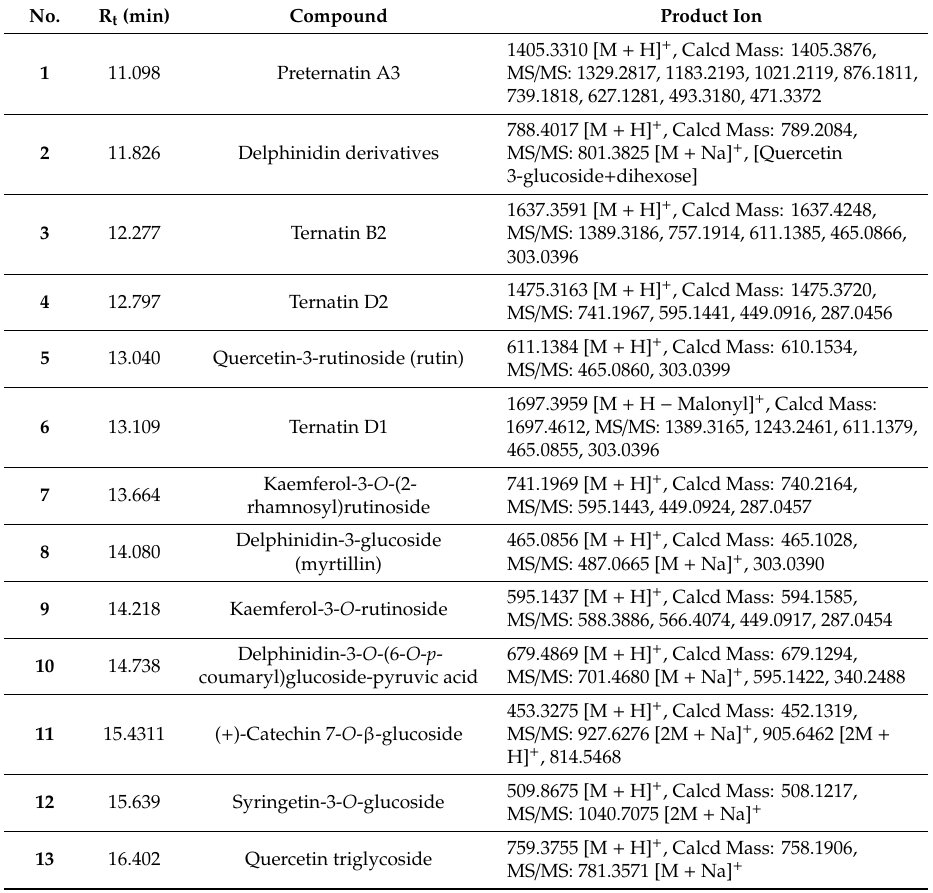
Figure 1. LC-MS / MS chromatogram of the Clitoria ternatea flower extract (CTE). ( A ) The expanded range of CTE chromatogram during 0–18 min. ( B ) The profile of CTE chromatogram (the number indicates isolated compounds). Table 1. Chromatographic MS and MS / MS data and the chemical structure of identified compounds in CTE .